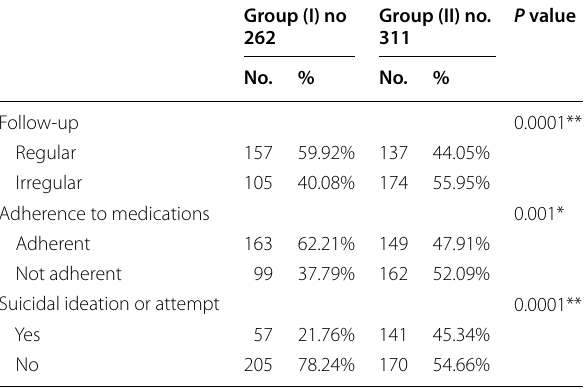
Table 3 Impact of psychiatric disorder stigma on group I and group II patients